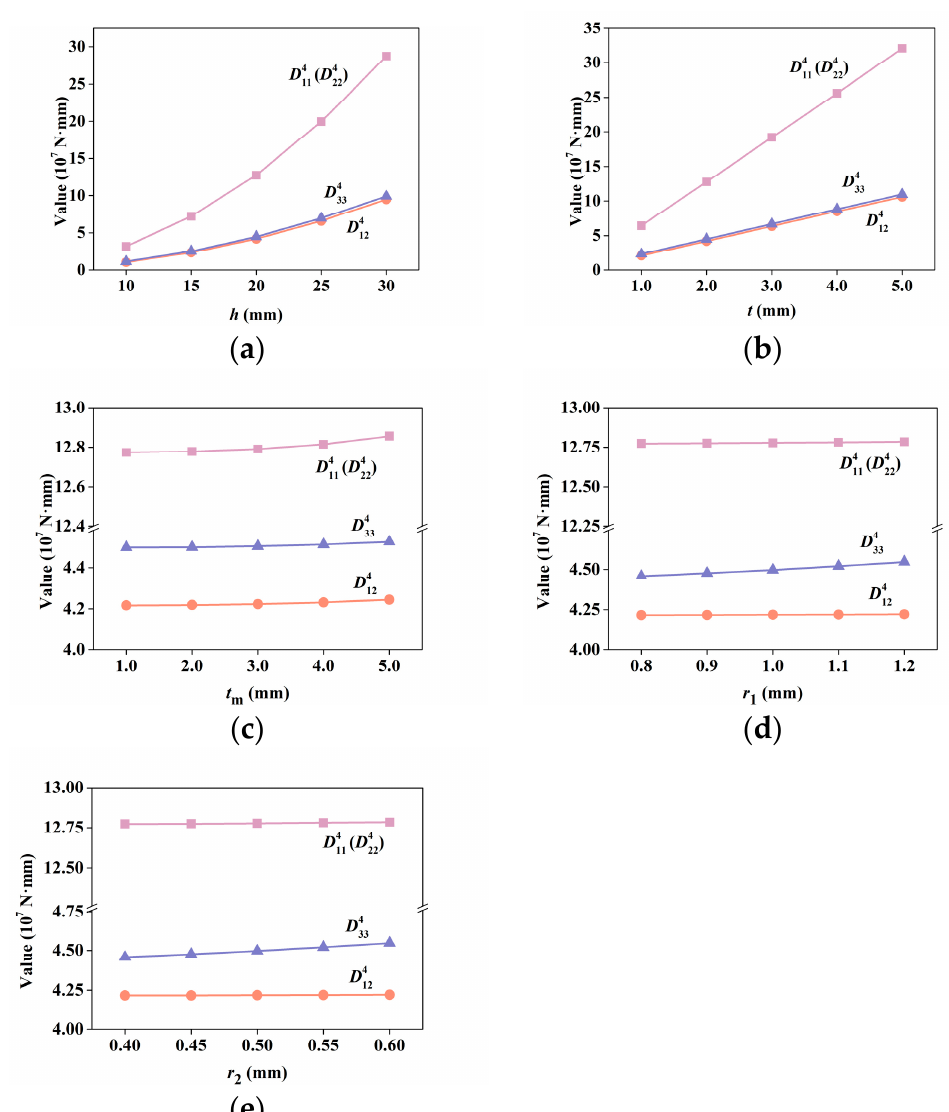
Figure 8. Bending stiffness coefficients in D 4 by S-NIAH versus various unit cell parameters ( h , t , t m , r 1 , and r 2 ): ( a ) lattice height h , ( b ) upper and lower bound plate thickness t , ( c ) inner plate thickness t m , ( d ) radii of robs in spare layer r 1 , and ( e ) radii of robs in dense layer r 2 . The variations in shear stiffness K versus various unit cell parameters are shown in Figure 9. The considered parameters are the same as mentioned earlier. The ratio of the shear stiffness to the bending stiffness is also shown in Figure 9. It can be seen that as the height increases, the shear stiffness increases, whereas ratio K 11 / D 4 which suggests that the bending stiffness increases more rapidly than the shear stiffness. As t increases, the shear stiffness shows little increase, whereas the ratio K 11 / D 4 decreases. With the other parameters, the shear stiffness and ratio K 11 / D 4 same trends of change. The results show that the contribution of the shear deformation to the total structural deformation rises when h or t increases, indicating an increase in the necessity of considering the shear